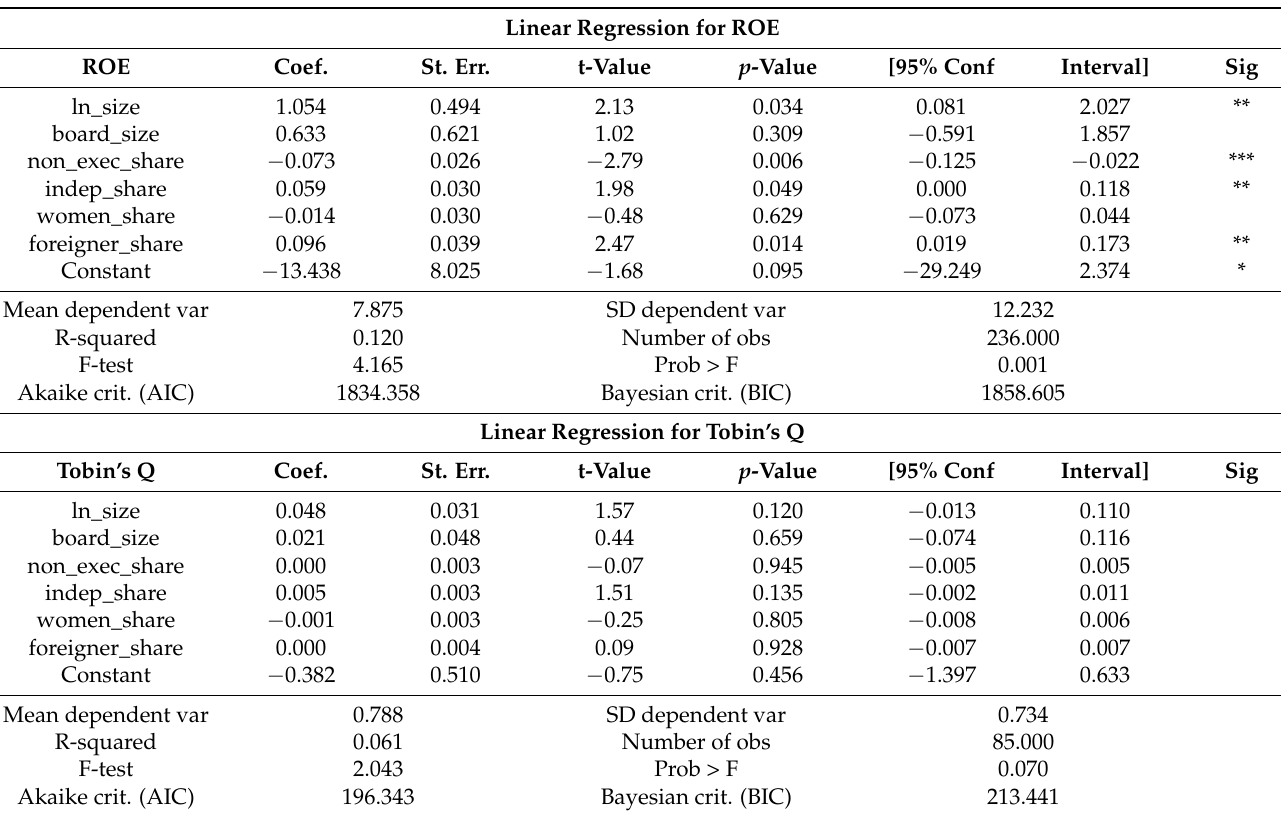
Table 4. Cont. Linear Regression for ROE